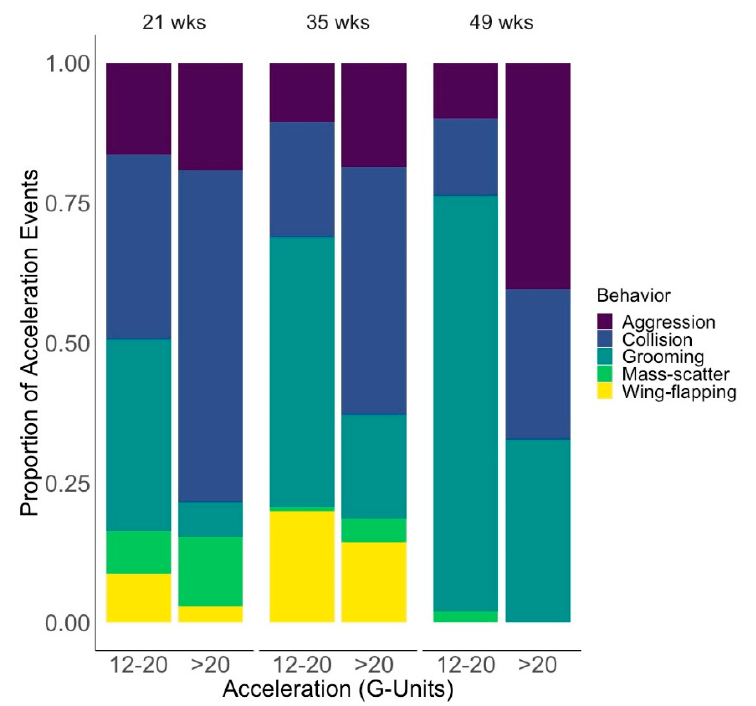
Figure 1. All identifiable acceleration events sustained by all hens at each age, grouped by behavioral category and acceleration category. At 21 weeks, the 12–20 G acceleration category is based on 184 events and the >20 G category is based on 209 events. At 35 weeks, 12–20 G represents 141 events while >20 G represents 70 events. Lastly, at 49 weeks, 12–20 G contains 101 events and >20 G contains 52